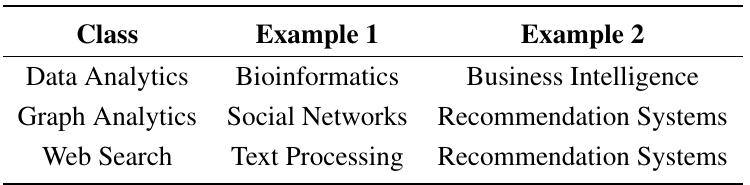
Table 1. Typical cloud computing